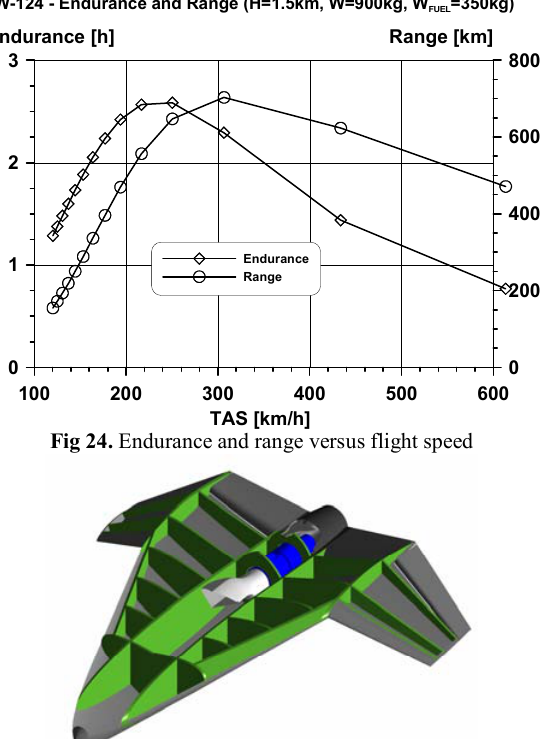
Fig 25. An approximated layout of aircraft structure